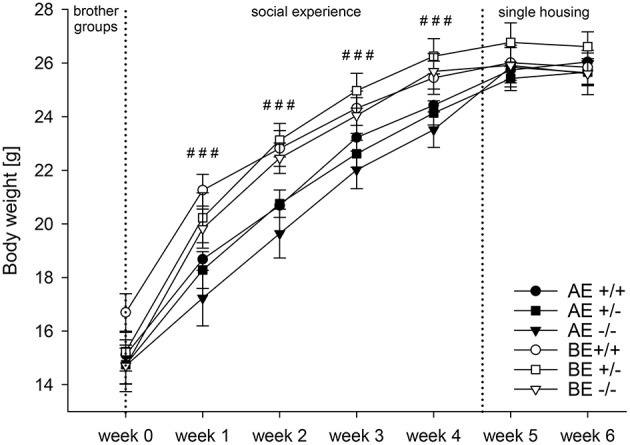
Body weight (in gram) measured weekly of male heterozygous (+∕−) and homozygous (−∕−) 5-HTT knockout mice and their wildtype counterparts (+∕+) that experienced either an adverse (AE, closed symbols) or beneficial (BE, open symbols) environment during adolescence (AE: 5-HTT +∕+ n = 12, 5-HTT +∕− n = 13, 5-HTT −∕− n = 13; BE: 5-HTT +∕+ n = 13, 5-HTT +∕− n = 13, 5-HTT −∕− n = 11). Values are presented as group means ± SEM. Univariate ANOVA: Effect of environment: ###
p ≤ 0.001. Different social experiences started in week 0 (dashed line) and lasted until week 4 (dashed line). Hereafter, animals were singly housed and no longer experienced different environments.